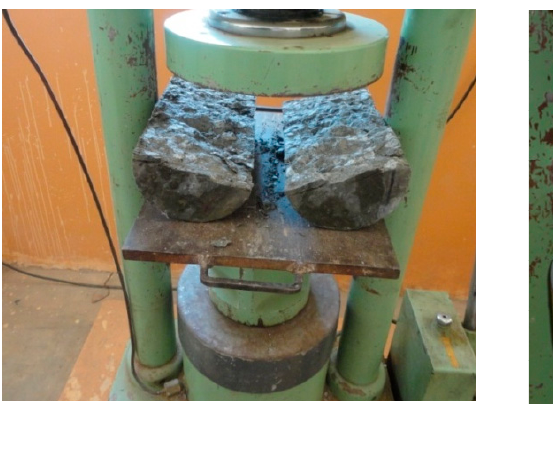
Figure 3. Specimens after compressive strength testing.